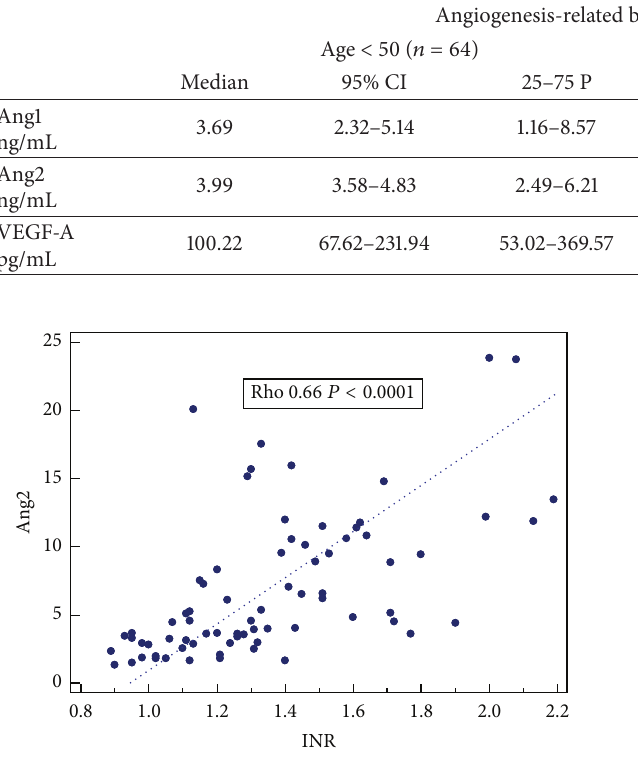
Figure 2: Correlation between Ang2 concentrations (ng/mL) and serum albumin levels